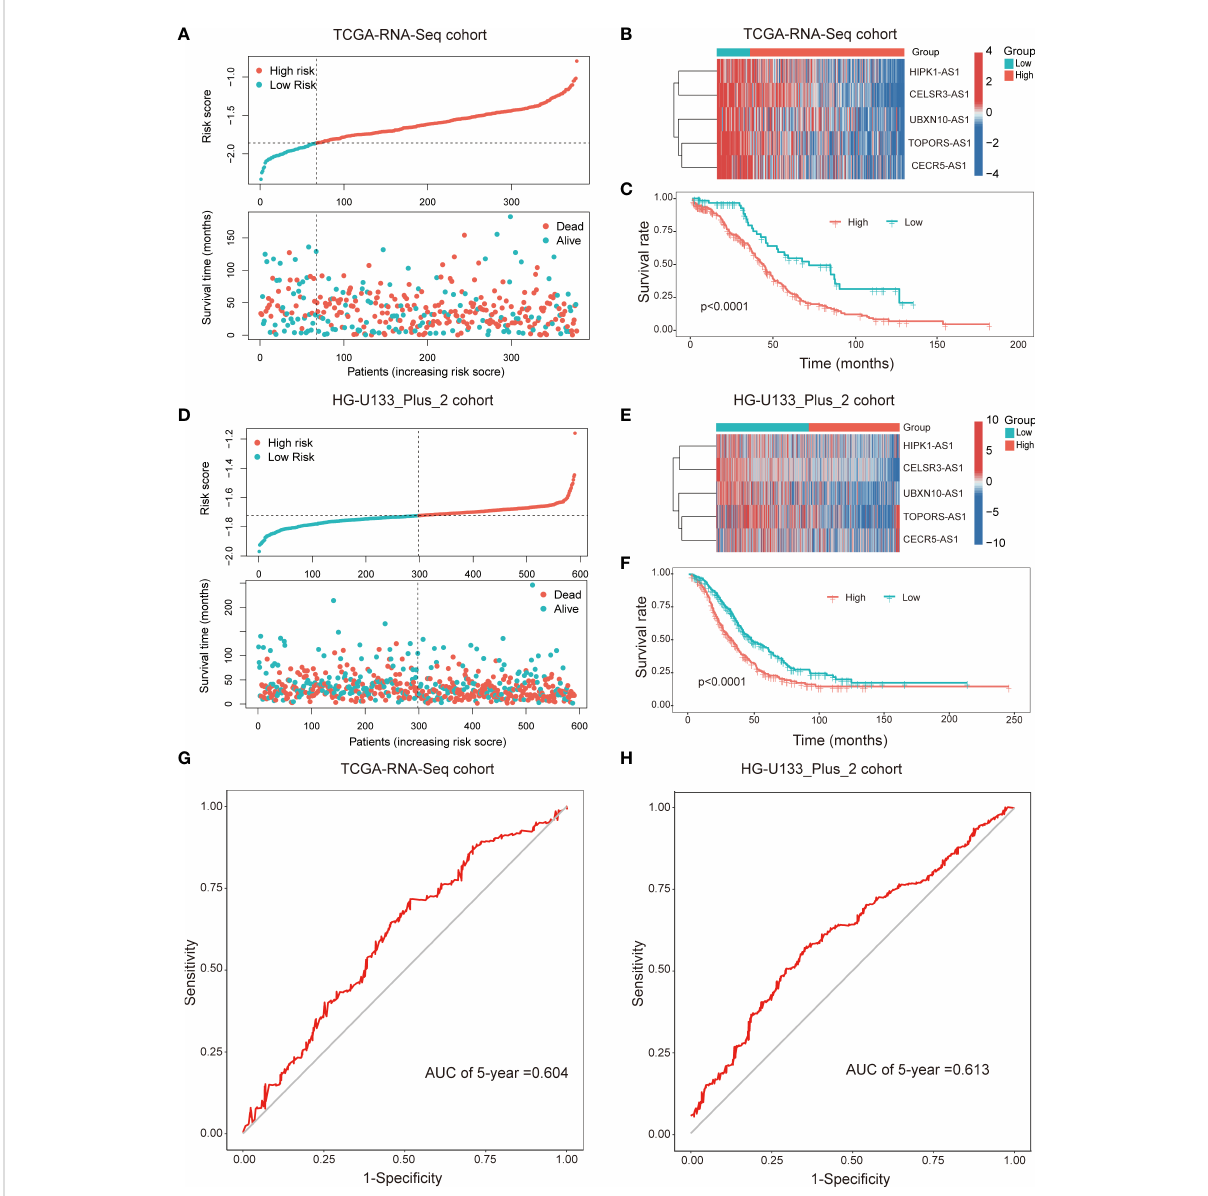
FIGURE 3 The immune-related prognostic signature was established and validated in TCGA-RNA-Seq cohort and HG-U133_Plus_2 cohort, respectively. Distributions of risk scores and survival status of OC patients in the TCGA-RNA-Seq cohort (A) and HG-U133_Plus_2 cohort (D) ; Heat map analysis showed the association between risk score and the expression of the fi ve lncRNAs in TCGA-RNA-Seq cohort (B) and HG-U133_Plus_2 cohort (E) ; Kaplan – Meier curves showed that the high-risk subgroup had worse OS than the low-risk subgroup in TCGA-RNA-Seq cohort (C) and HG-U133_Plus_2 cohort (F) . ROC curves of the immune-related lncRNAs for predicting 5-year survival in TCGA-RNA-Seq cohort (G) and HG-U133_Plus_2 cohort (H)